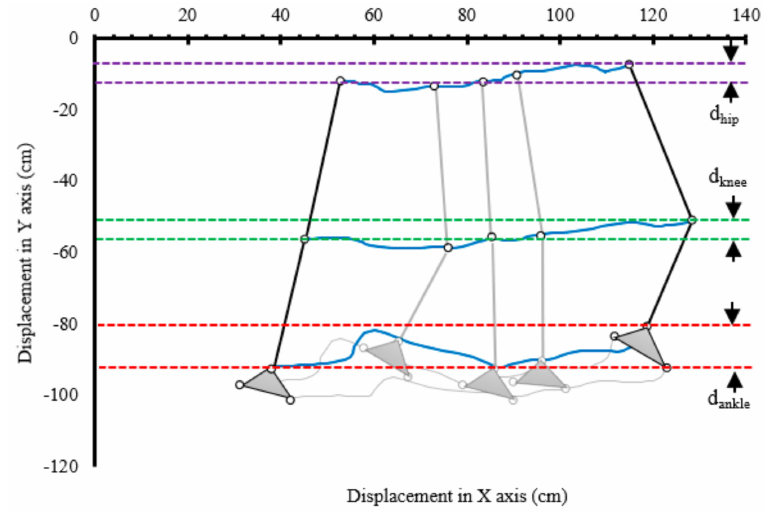
Figure 15. Vertical displacements of foot joints during the gait